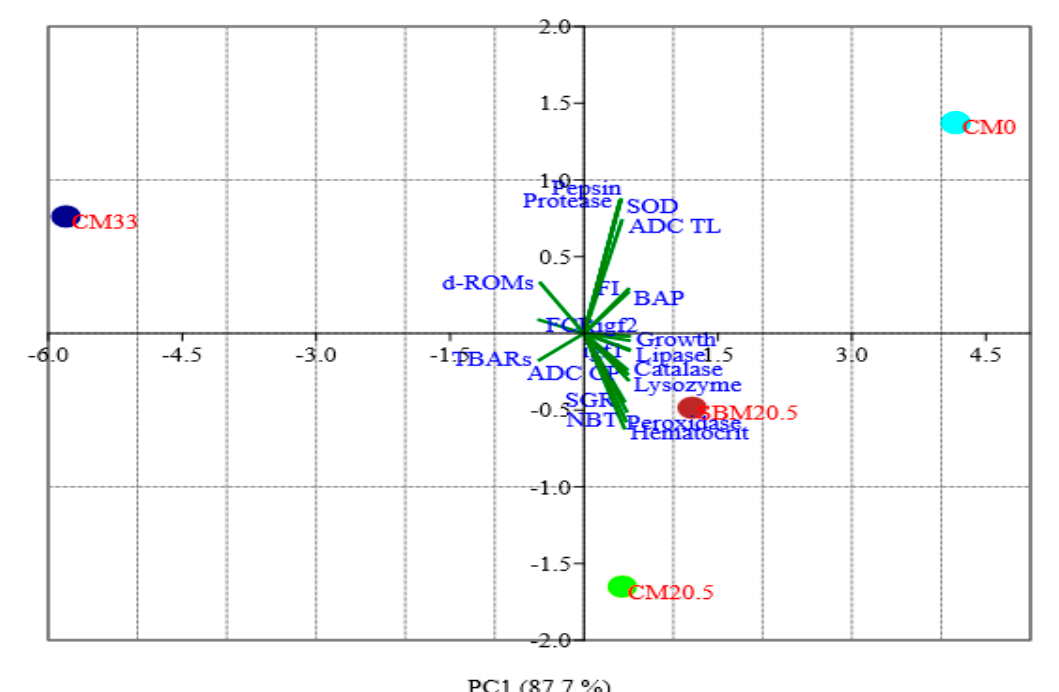
Figure 6. Principal component analysis (PCA) plot (PC: 1:87.7%, PC: 9.04%) correlation of responses of growth, feed utilization indices, immunity markers, stress biomarkers, relative gene expressions, digestibility coefficients, and enzyme activity of red seabream using a covariance, where fours diet treatments formulated by replacing fish meal with camelina meal at 0% for reference diet (CM0), 20.5 g/kg with soybean mean (SBM20.5), 20.5 g/kg with camelina meal (CM20.5) and 33 g/kg camelina meal (CM33).